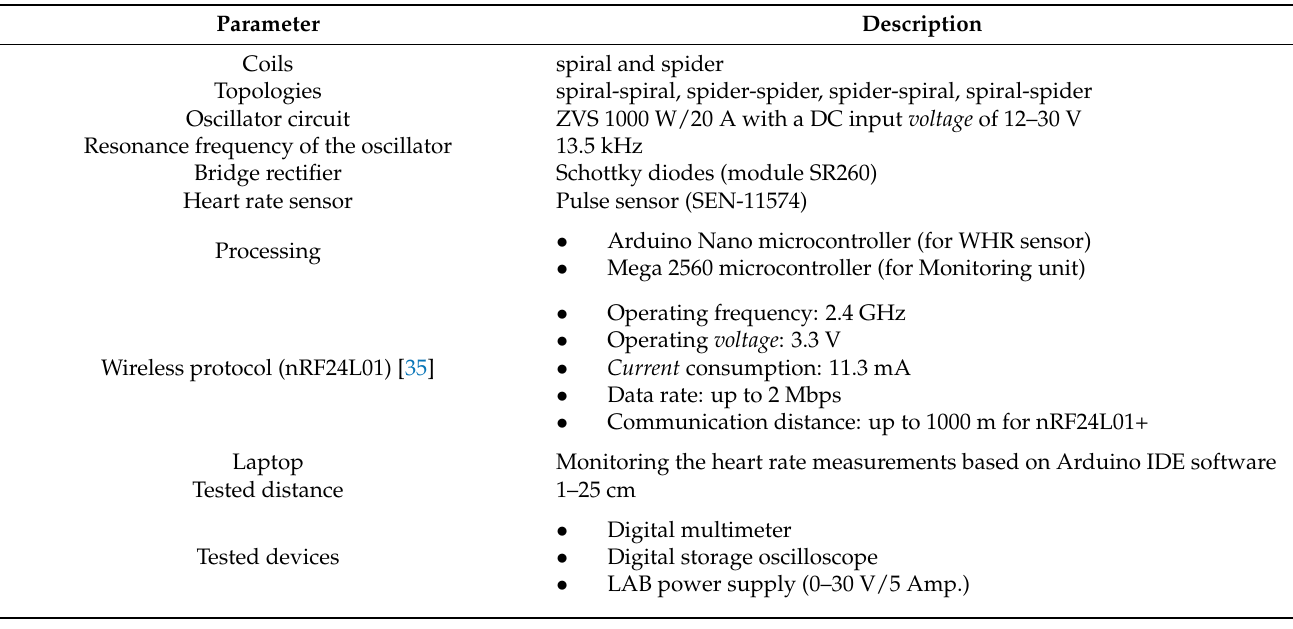
Table 3. Experimental protocol and the test parameters adopted in the current experiment.